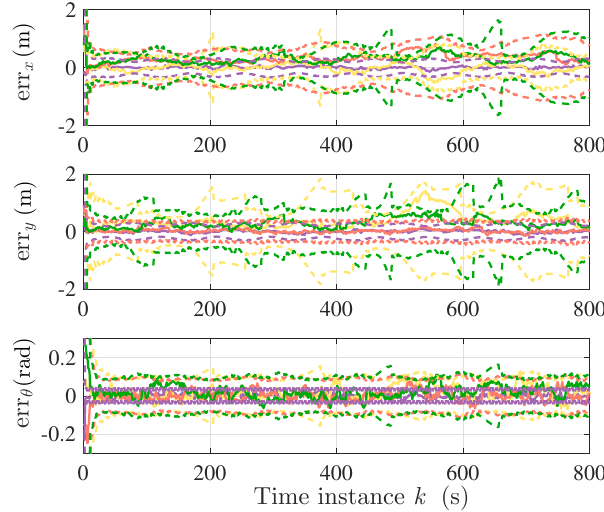
Figure 4. Estimated trajectories of robots and the target in different colors (black dashed lines indicate the ground truth).